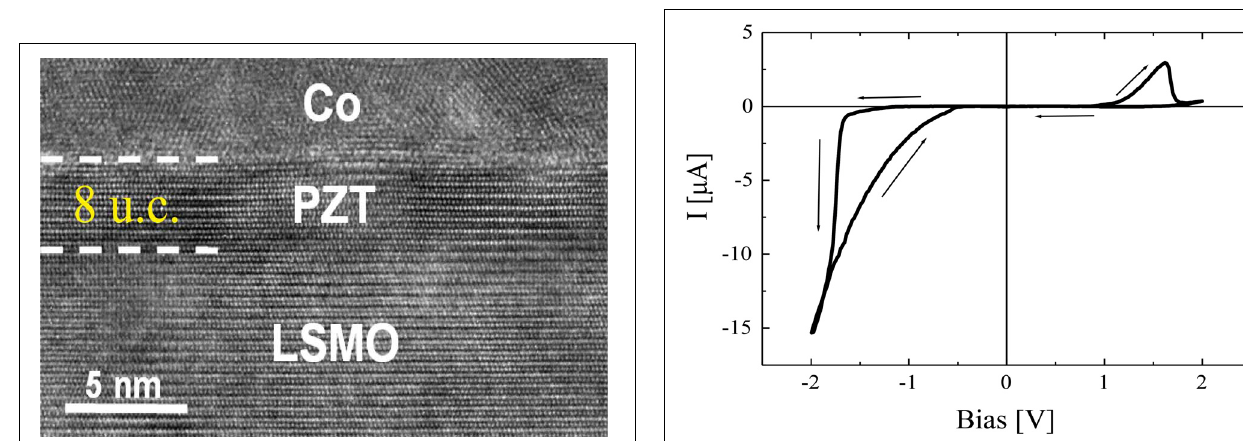
FIGURE 1 | High-resolution transmission electron micrograph of the Co/PZT/LSMO tunnel junction used in the present study. The thickness of PZT is 8 unit cells (about 3.2nm).